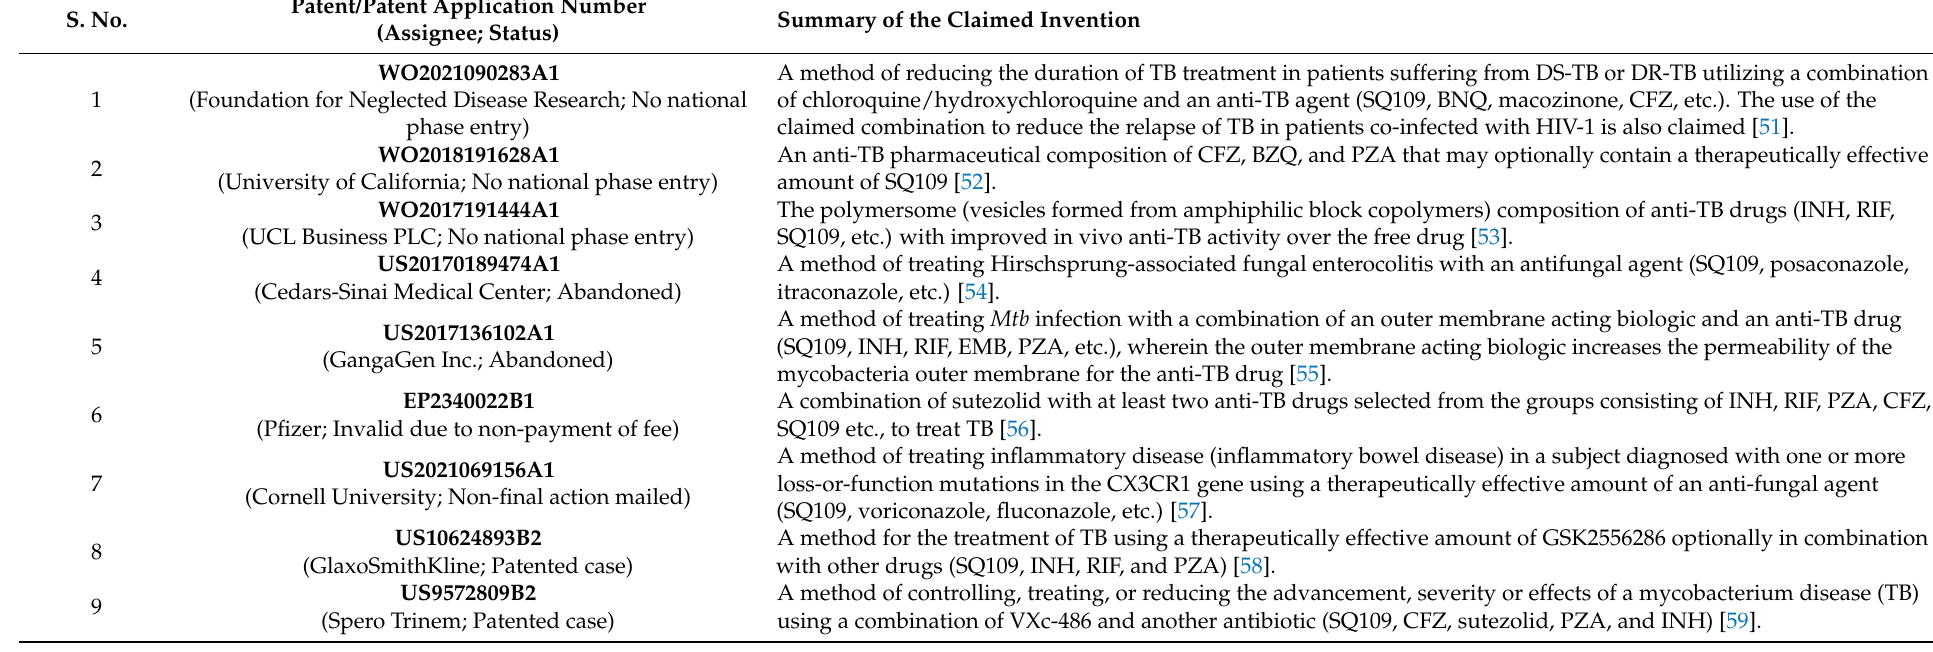
Table 4. Patents/patent applications of SQ109 without experimental details of the claimed SQ109